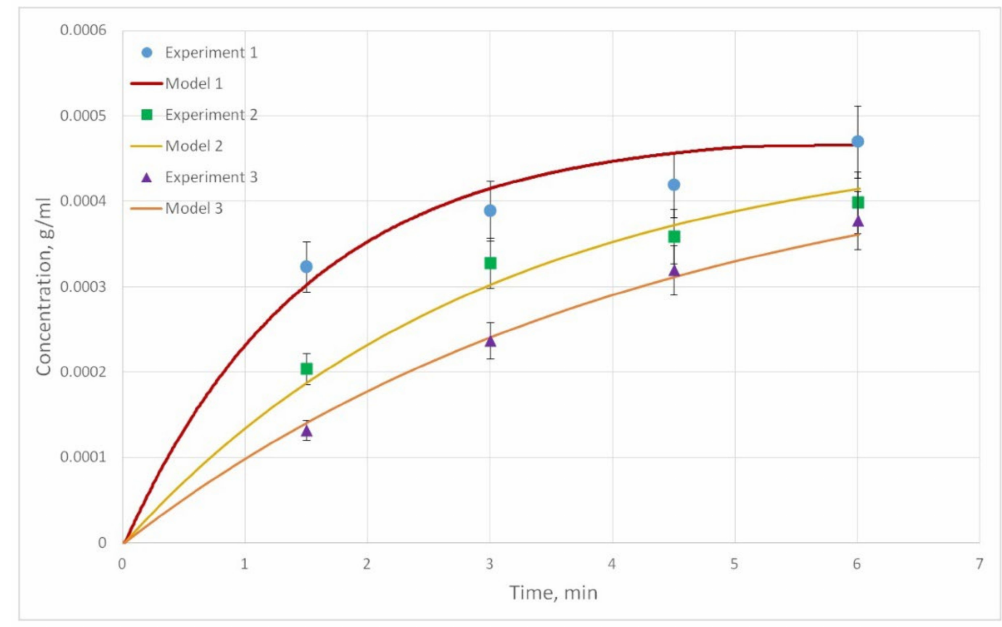
Figure 14. Calculated and experimental curves of melatonin release from chitosan-based aerogel